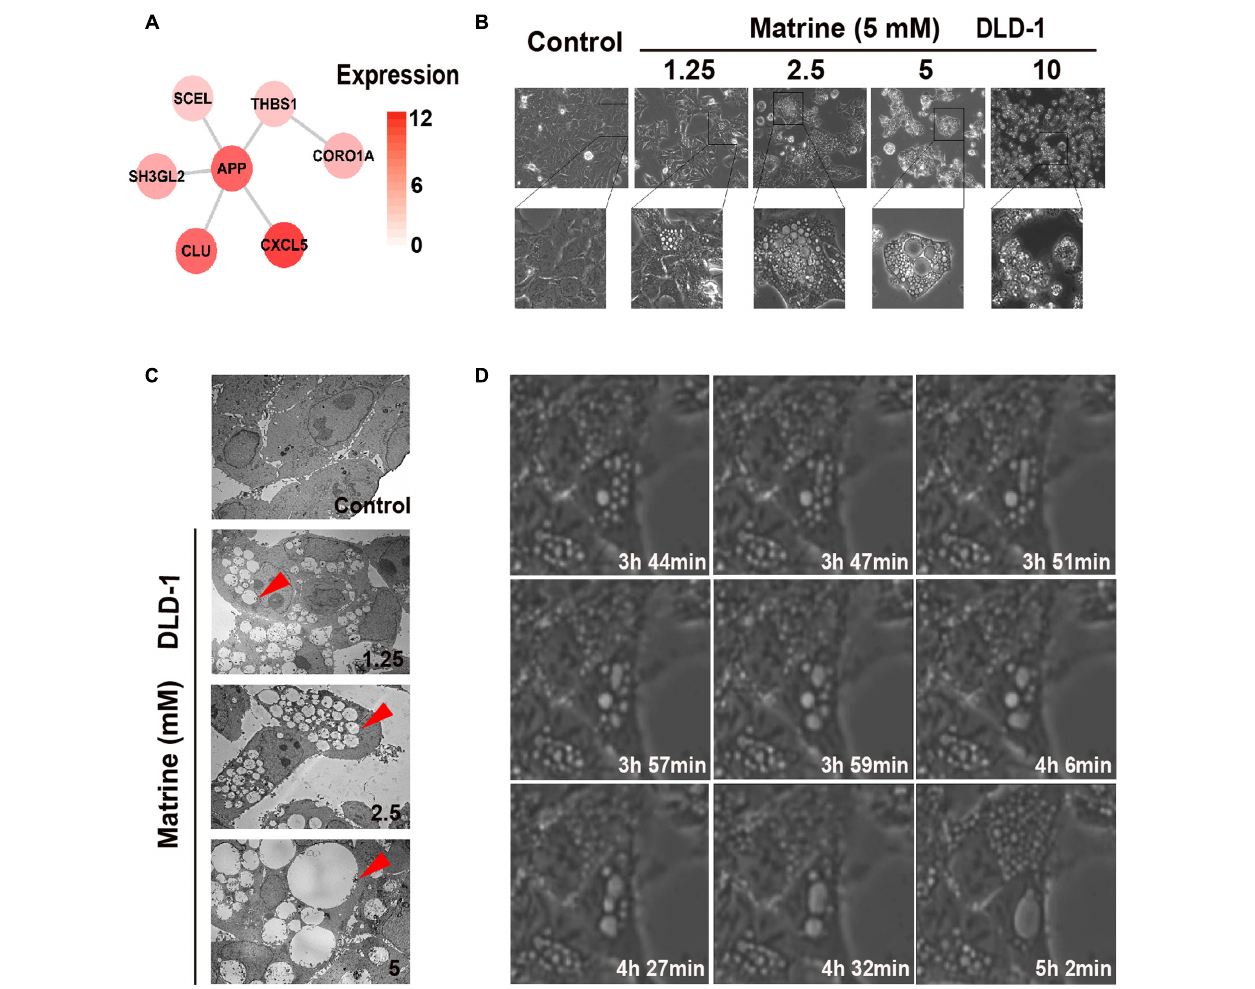
FIGURE 4 | Matrine induces vesicle formation, endocytosis and macropinocytosis in a time-and concentration-dependent manner. (A) The endocytosis-associated network module of matrine with expression in DLD-1. (B) Phase-contrast microscopy of the matrine-treated DLD-1 cells for 12 h shows extensive accumulation of cytoplasmic vacuoles and cell detachment in a concentration-dependent manner. (C) TEM images of matrine-treated DLD-1 cells at different concentrations for 12 h. Red arrow points at cytoplasmic vacuoles. Bar, 10 µ M. (D) Live imaging of DLD-1 cells (5 mM matrine). Images collected at times of major phenotypic